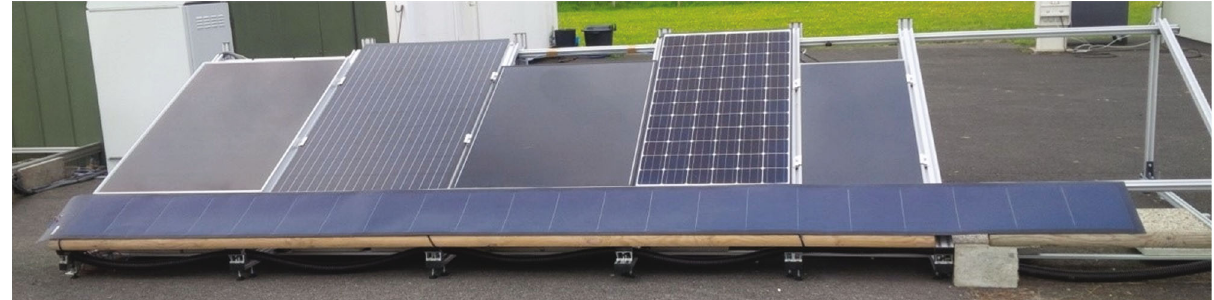
Figure 2: Outdoor characterization PV platform located at